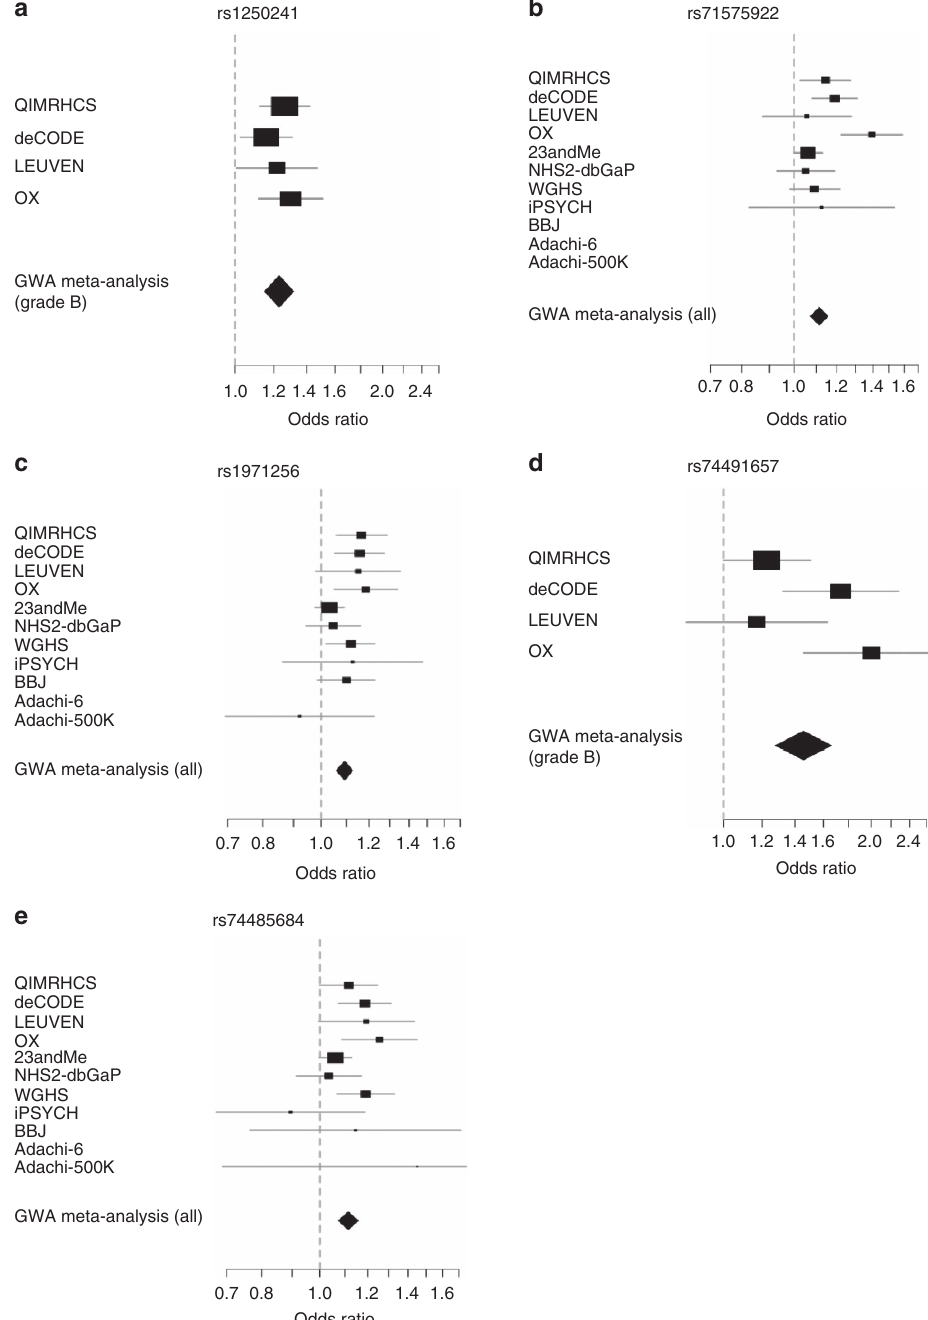
For the FN1 2q35 and 7p12.3 loci, we used summary statistics from meta-analysis including Grade B endometriosis cases.